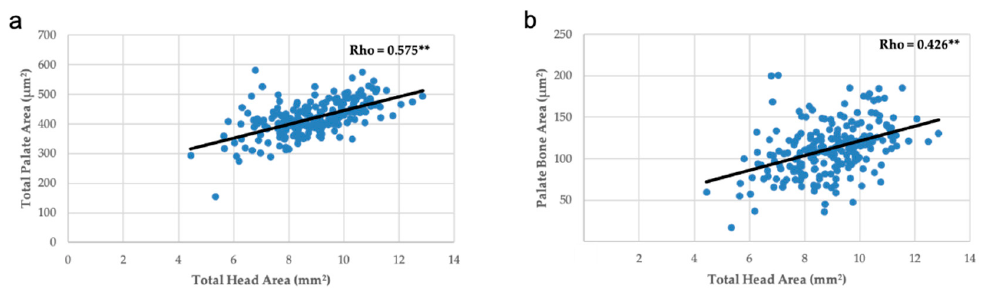
Figure 8. Correlations between palate measurements and total head area. ( a ) Total palate area and ( b ) palate bone area. ** p ≤ 0.01; Spearman’s Rho. Nutrients 2021 , 13 , x FOR PEER REVIEW